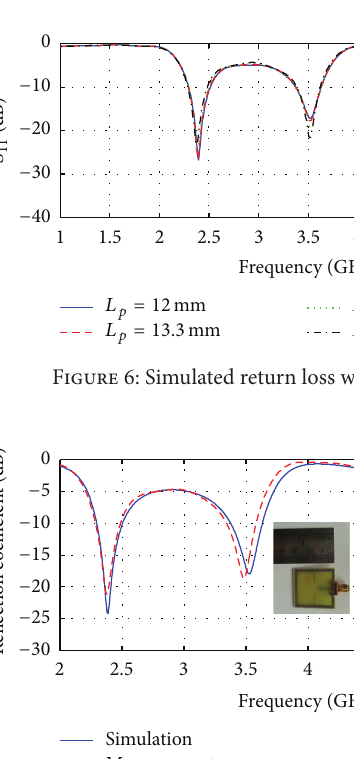
Figure 5: Simulated return loss with different 𝐿 𝑠 .